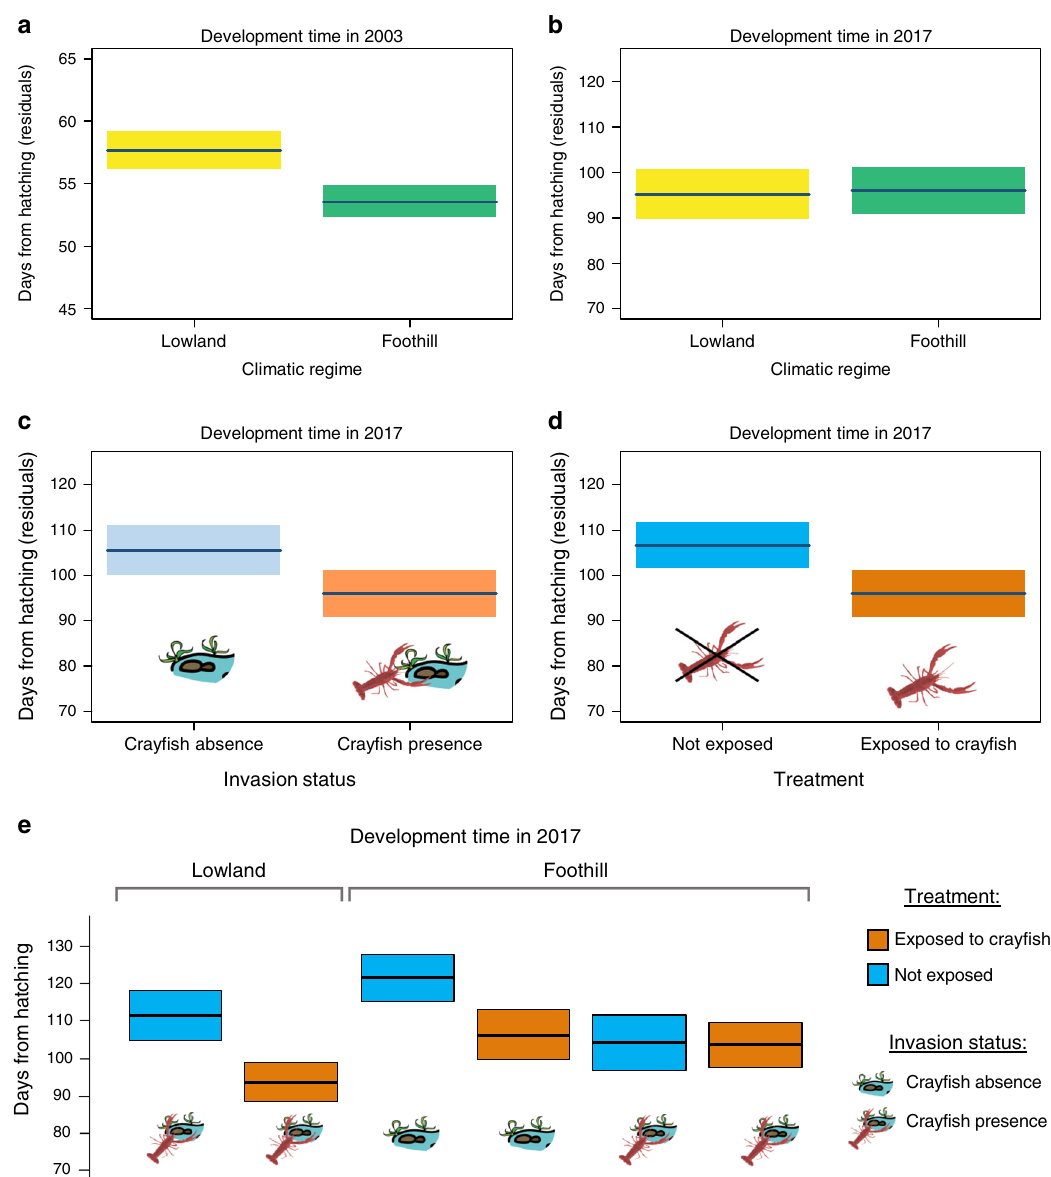
Fig. 2 Factors affecting development time (days from hatching) of Italian agile frog, Rana latastei , tadpoles. Conditional partial residual plots showing the effect of a climatic regime before the cray fi sh invasion; b climatic regime after the cray fi sh invasion; c invasion status of the population and d cray fi sh exposure during rearing on development time (calculated as days from hatching to metamorphosis). Bold blue lines represent the average value obtained using mixed models, while shaded areas are 95% con fi dence bands. e Boxplots showing the simultaneous effect of climatic regime, invasion status and experimental cray fi sh exposure on development time of tadpoles. Orange boxes represent tadpoles exposed to the cray fi sh during rearing, while blue boxes represent individuals not exposed. Images of ponds with cray fi sh represent invaded populations, while those with no cray fi sh represent the uninvaded ones. All the lowland breeding sites are colonized by the invasive cray fi sh. The black line represents the mean value while the box limits are ±2 standard errors. In panel ( a ), n = 180 tadpoles; in panels ( b – e ), n = 169 tadpoles. Source data are provided as a Source data fi